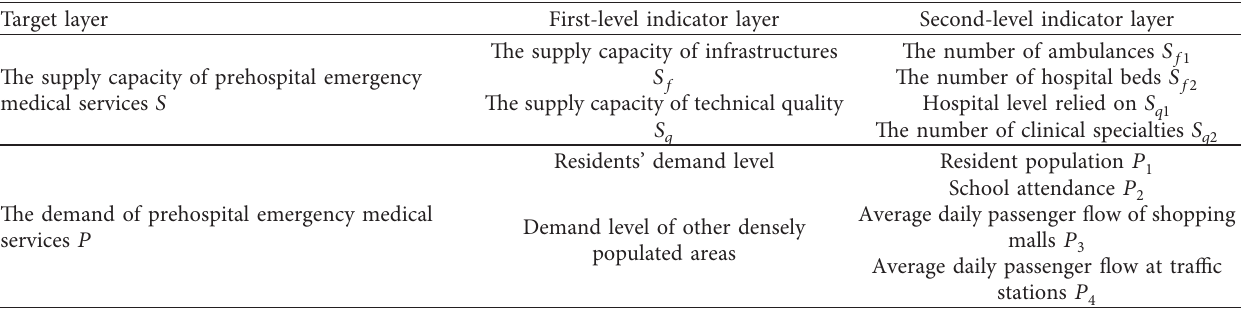
Table 1: Indicators of supply and demand of prehospital emergency medical